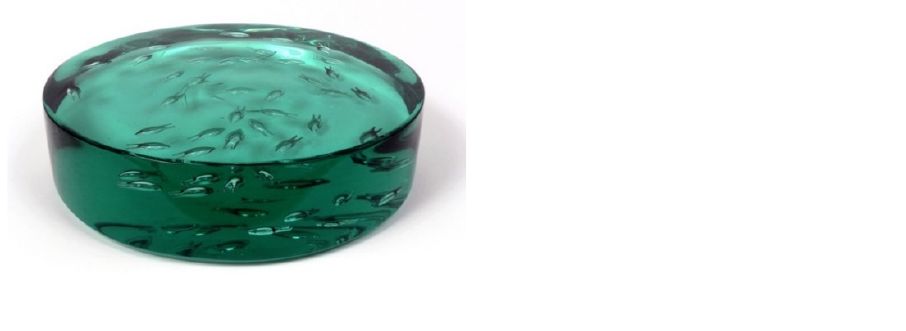
Figure 17. Joanne Mitchell, Host II, waterjet cut glass, kiln cast with ariel entrapment, 2015. Courtesy of the artist, used with permission.